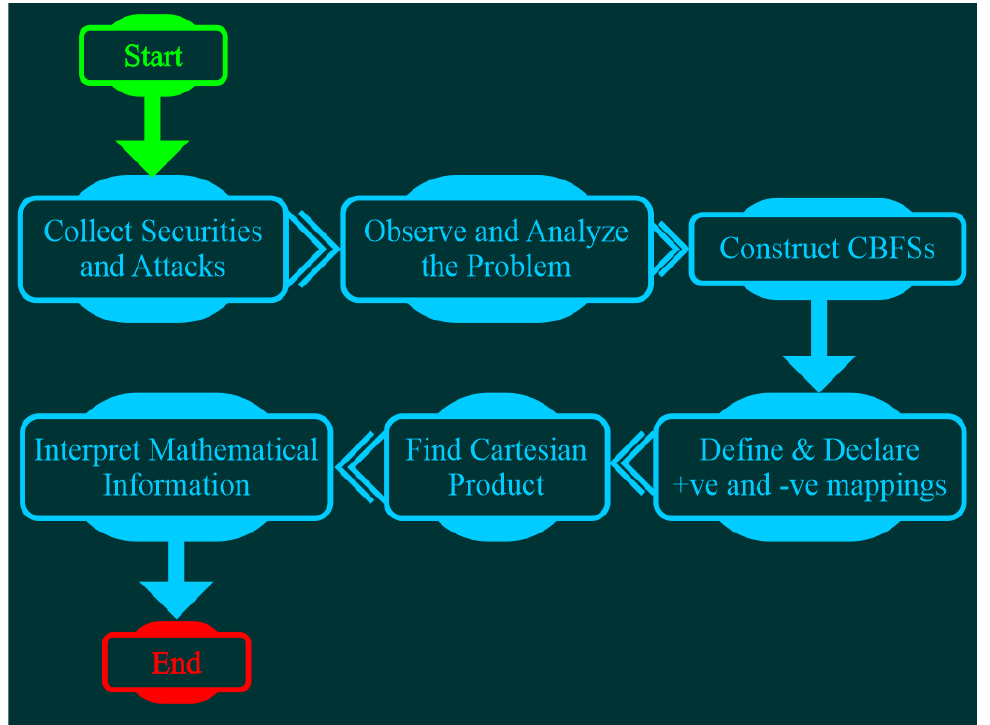
Figure 2. Algorithm for the proposed method.